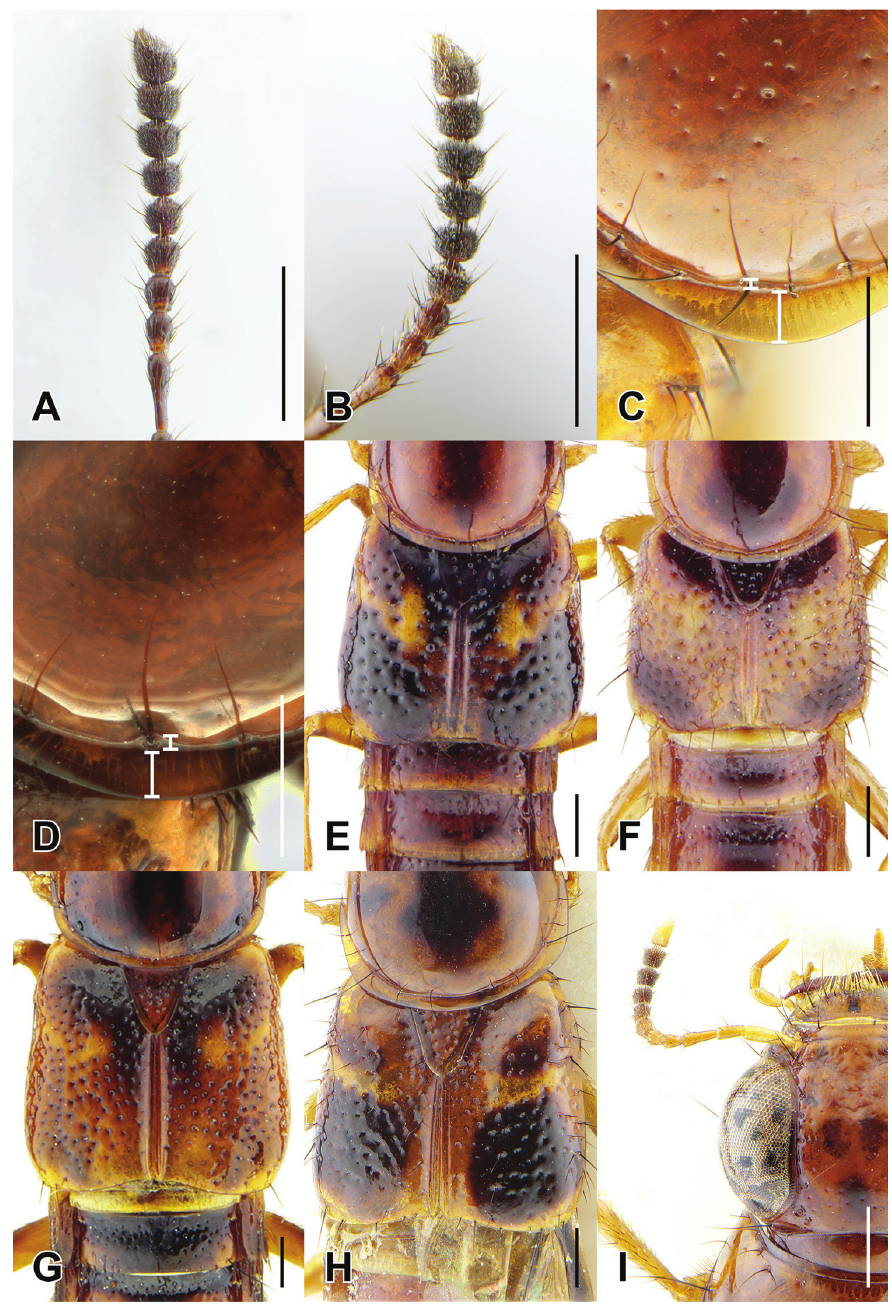
Figure 4. Antenna: Bolitogyrus electus Smetana & Zheng ( A ) and B. confusus Brunke ( B ). Posterior angle of pronotum: B. caesareus (Bernhauer) ( C ) and B. elegans (Cameron) ( D ). Elytra: B. elegans ( E ), B. smetanai Brunke ( F ), B. tigris Brunke ( G ) and B. luteus ( H ). Dorsal head: B. luteus ( I ). Scale bars: 0.5 mm ( A–C, E–I ), 1 mm ( D